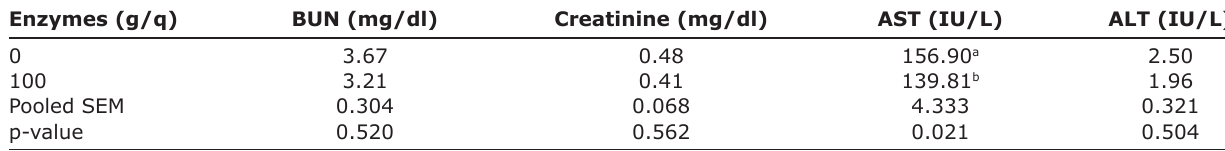
Table-7: Effect of feeding different levels of citrus waste on the liver and kidney function tests in broiler. Enzymes (g/q)